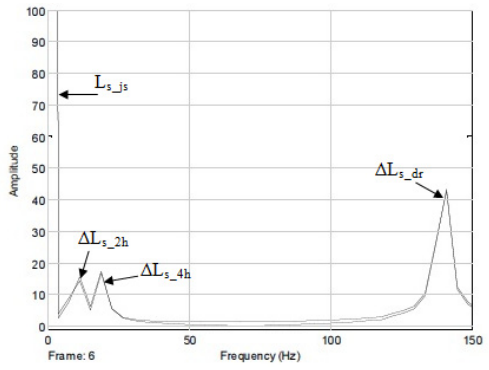
Figure 16. Frequency spectrum of stator inductance.